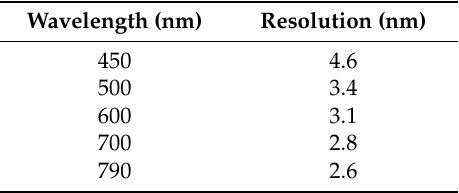
Table 1. Spectral resolution for fiber #38.